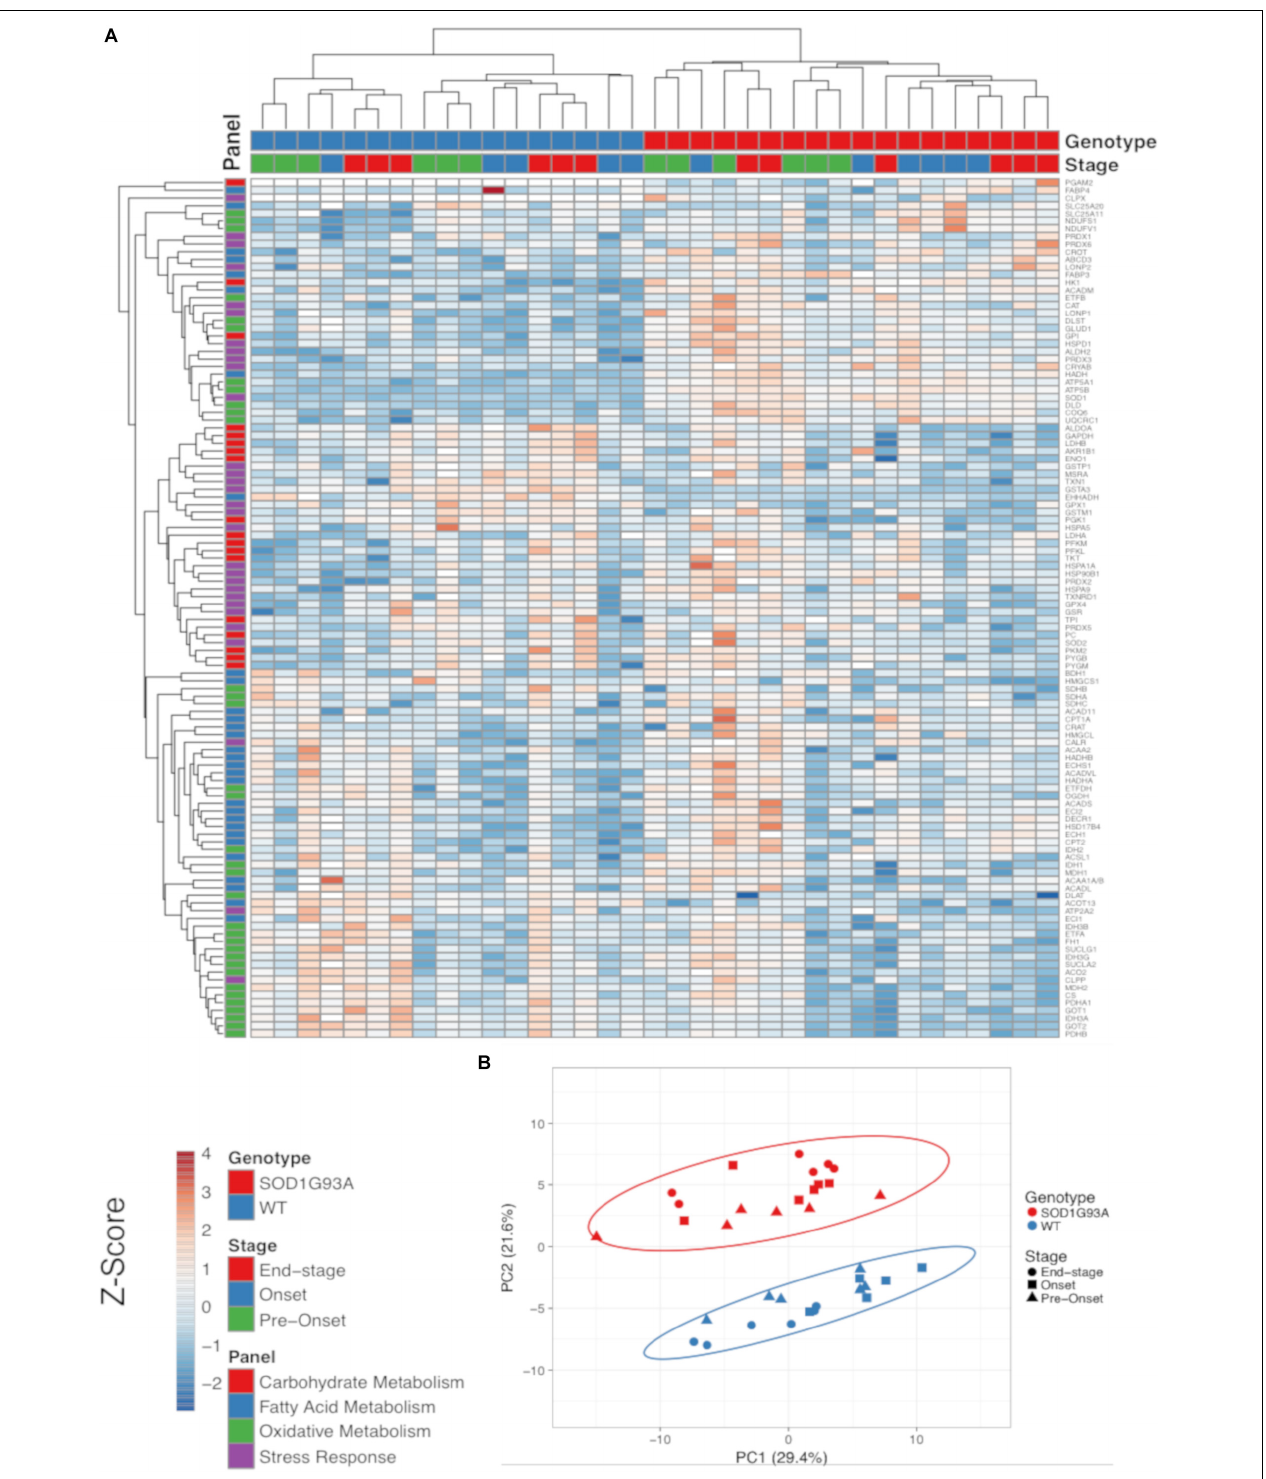
FIGURE 1 | Metabolic pathways are differentially regulated in the spinal cord of SOD1 G93A mice, and stress response proteins are induced. Protein content from spinal cords of pre-onset, onset, and end-stage control and SOD1 G93A mice ( n = 5–6) measured by mass spectrometry. The assayed proteins were targeted for representative panels of carbohydrate metabolism, fatty acid metabolism, oxidative mitochondrial metabolism (tricarboxylic acid cycle and electron transport chain), and stress response (antioxidants, chaperones, heat shock proteins, and proteases). (A) Heatmap with clustering for each sample using a Z-score scale. (B) Principal component analysis (PCA) plot for principal components 1 and 2. Protein names, IDs, and absolute expression values are detailed in Supplemental Table 1 .